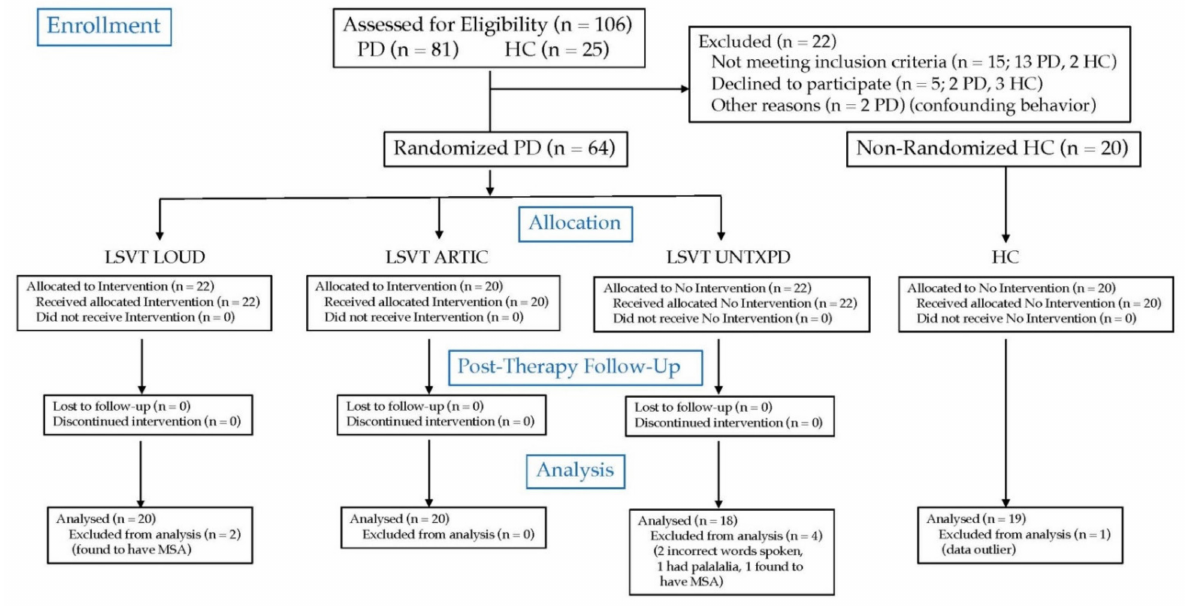
Figure 1. CONSORT diagram outlining the flow of participants through the trial. PD: Parkinson’s disease; HC: Healthy